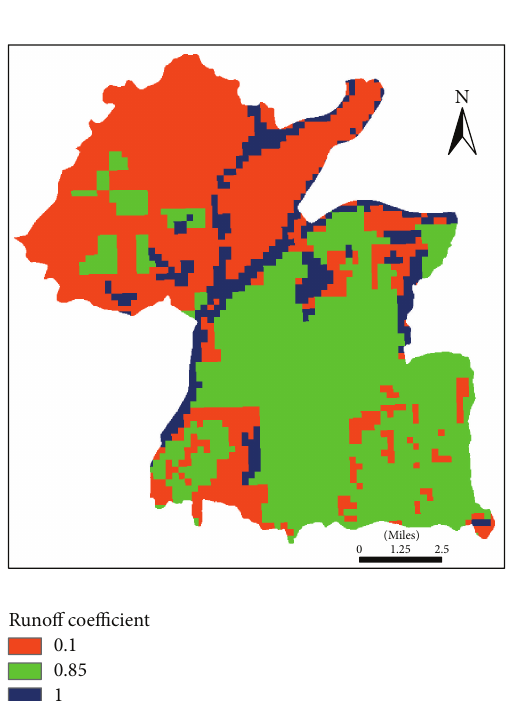
Figure6:Distributionmapofrunoffcoefficientdeterminedaccord- ing to Table